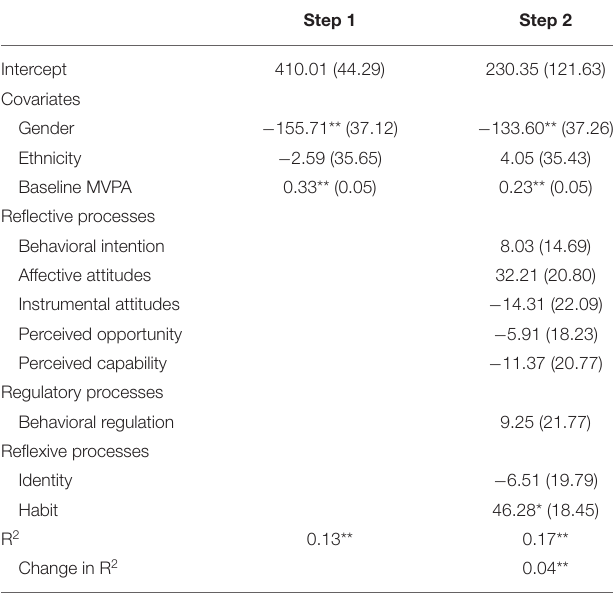
TABLE 3 | Results from mixed effects model predicting MVPA at follow-up from predictors at baseline. Step 1 Step